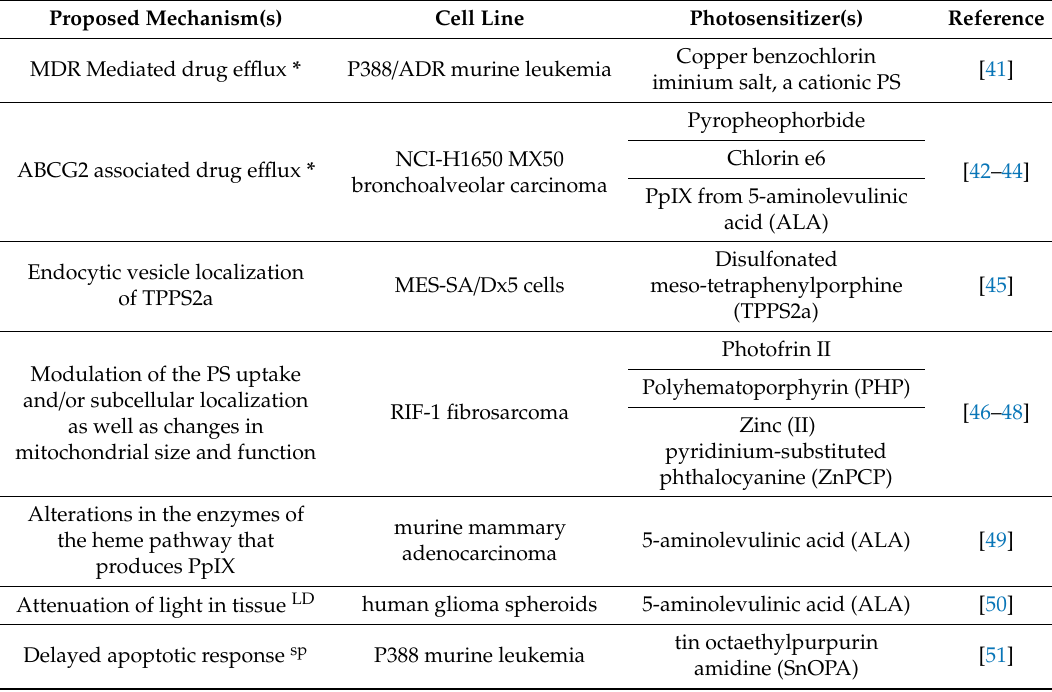
Table 1. Photodynamic therapy (PDT) resistance